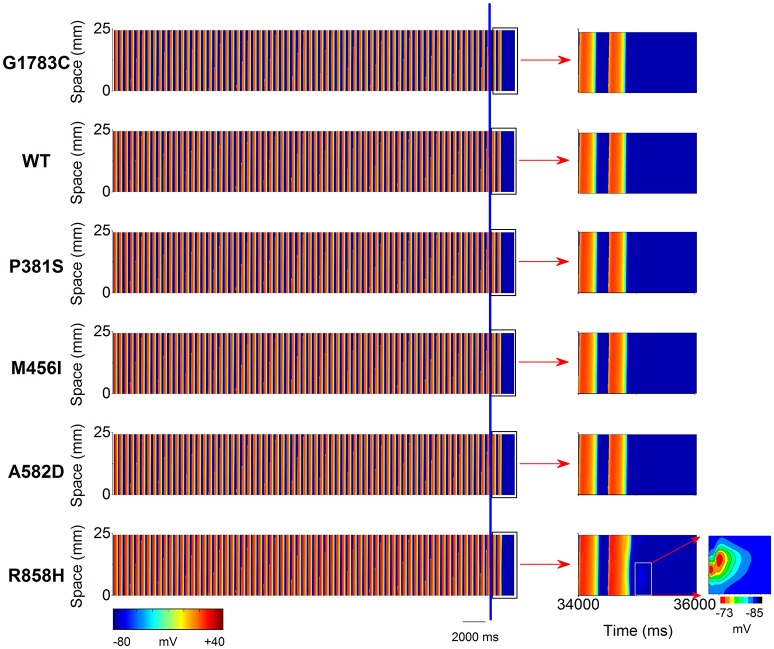
Space-time plots of midmyocardial action potential propagation in a one-dimensional (1D) homogeneous ventricular cable at the pacing cycle length (PCL) of 500 ms. Color mappings of membrane potential (left column) are shown under G1783C, wild-type (WT), P381S, M456I, A582D, and H858R conditions, respectively. The last two beats (the part on the right of the blue line) obtained from 34,000 to 36,000 ms (right column, marked with a black rectangle). A local region (marked with a white rectangle) close to the pacing site exhibiting a subthreshold delayed afterdepolarization (DAD) with no premature ventricular complex (PVC) under the R858H condition. Changes in membrane potential of the local region are indicated by an enlargement of the marked zone. Color mapping of membrane potential from blue (−85 mV) to red (−73 mV).